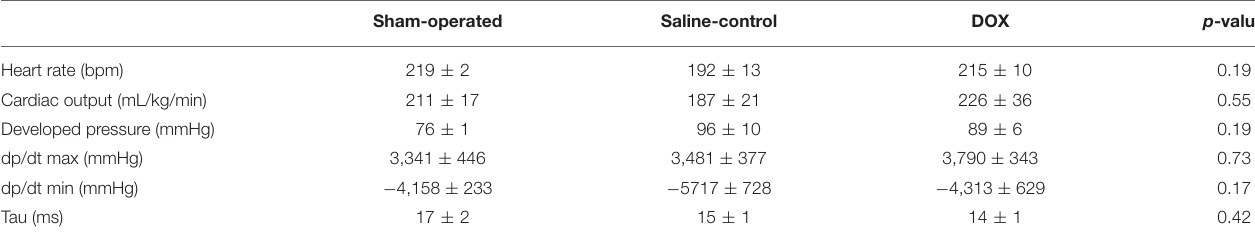
TABLE 3 | Left ventricular functions assessed by Millar ® catheter in anesthetized newborn piglets after 4 days recovery.